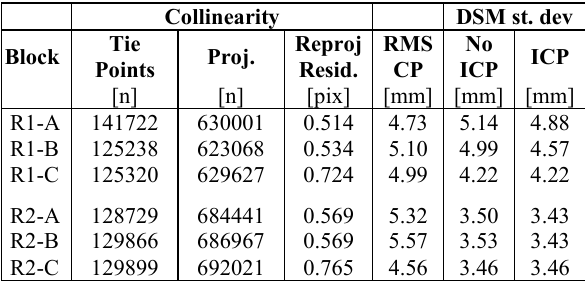
Table 2. Stats on collinearity, CP residuals and DSM comparison. 24 and 22 CP are used for R1 and R2